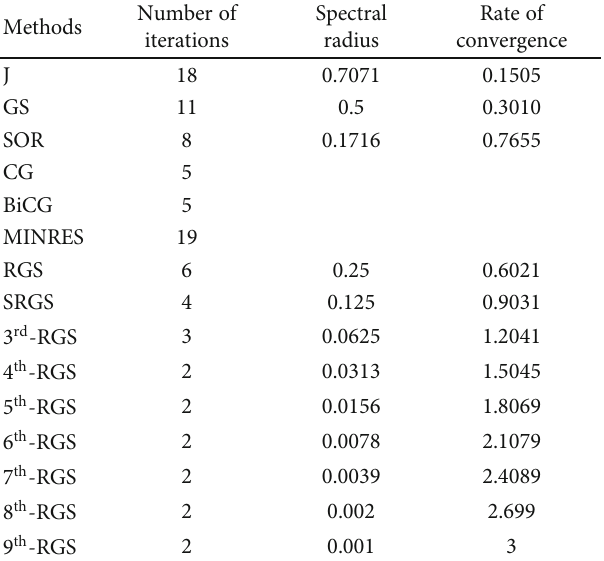
Table 3: Comparison of J, GS, SOR, and GRGS